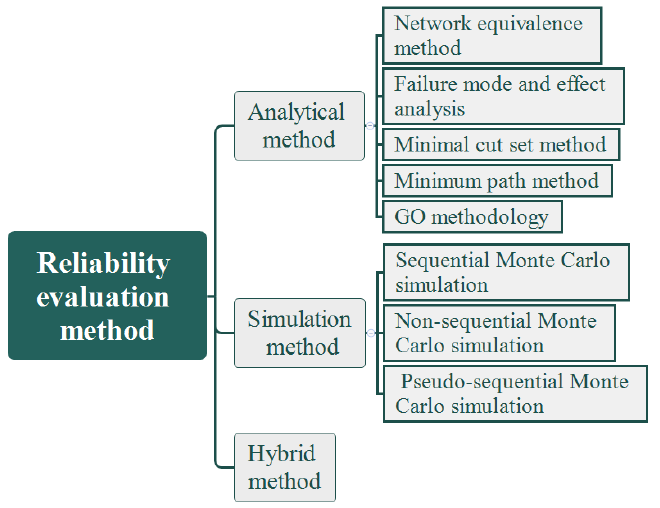
Figure 2. Classification of evaluation methods.